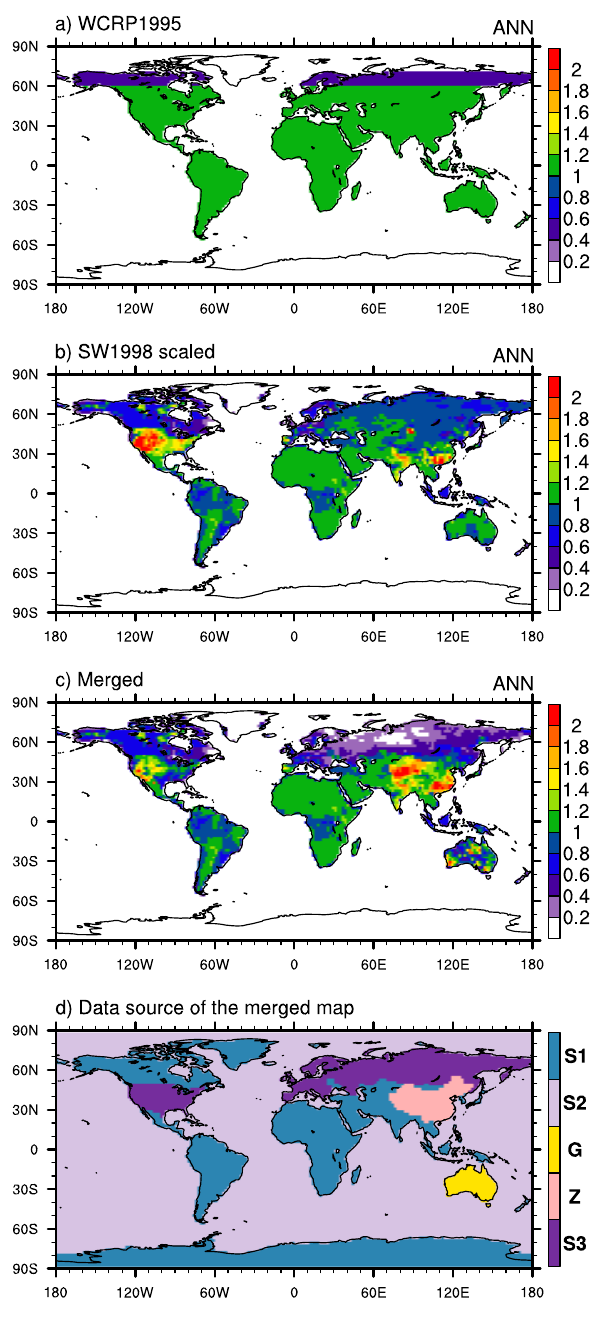
Fig. 2. (a–c) Radon emission setups considered in this study. The quantity shown is the annual mean atom number flux (unit: atomcm − 2 s − 1 ). (d) Data source of the merged emission map shown in (c) . S1 stands for Schery and Wasiolek (1998) (scaled), S2 for Schery and Huang (2004), G for Griffiths et al. (2010), Z for Zhuo et al. (2008), and S3 for Szegvary et al. (2007).